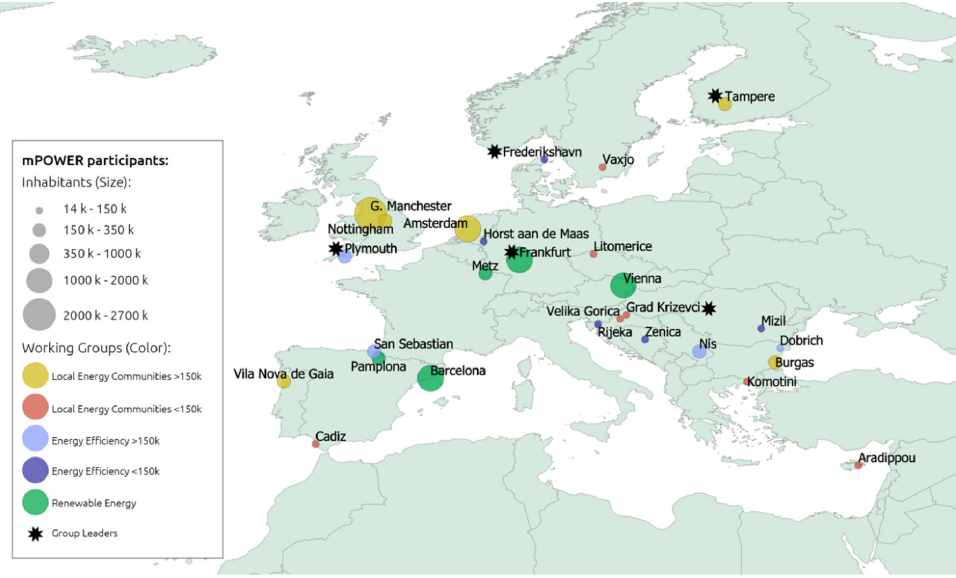
Figure 1. Municipalities selected for the mPOWER exchange programme. The selected 27 municipalities are classified in five different working groups.